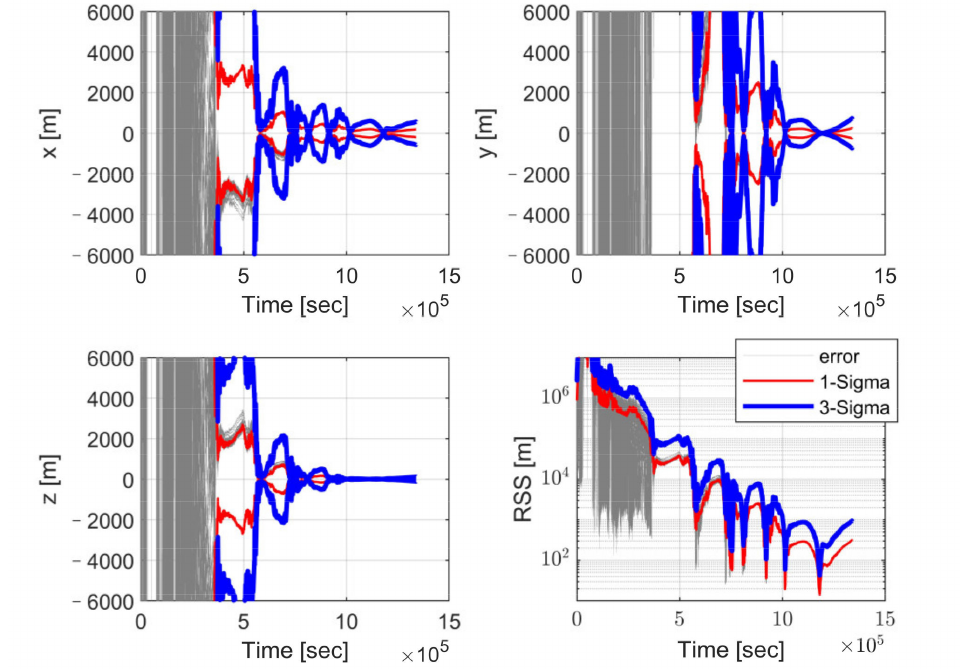
Figure 11. Angle-only navigation position errors along the resulting trajectory for 100 realizations and uncertainties (1-sigma uncertainty bound in red and 3-sigma uncertainty bound in blue) for the case with w =